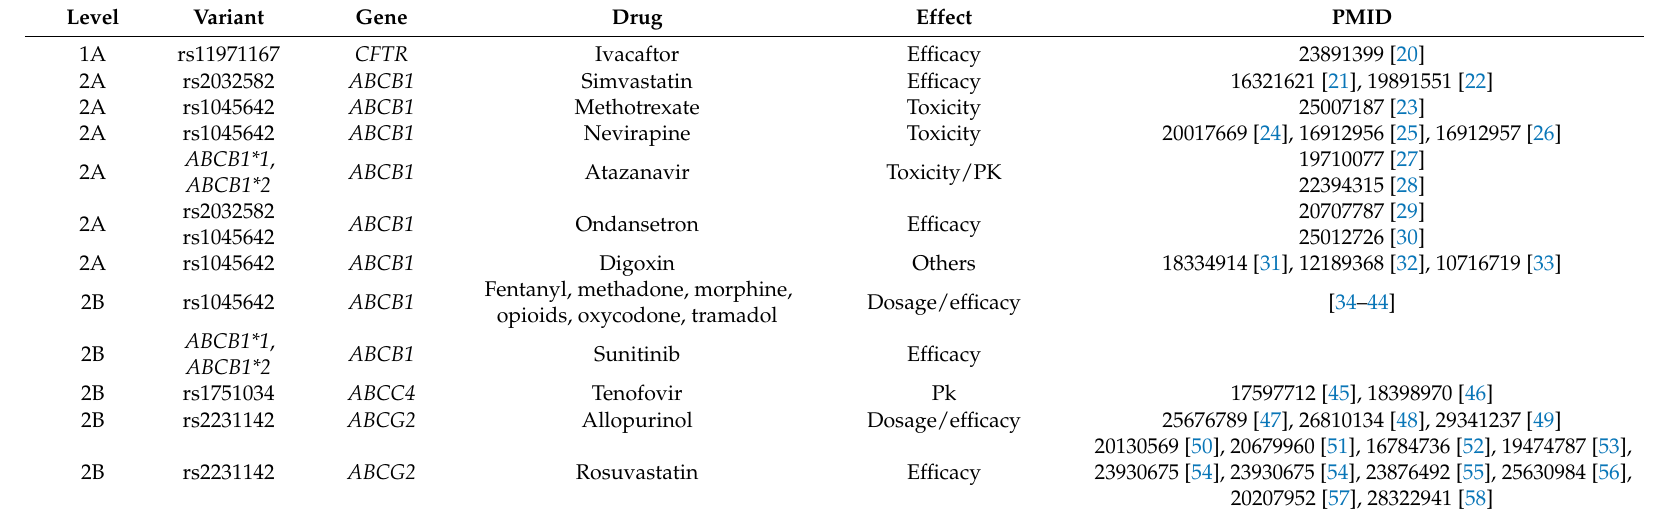
Table 1. ATP-binding cassette (ABC) transporter variants with a level of evidence from 1A to